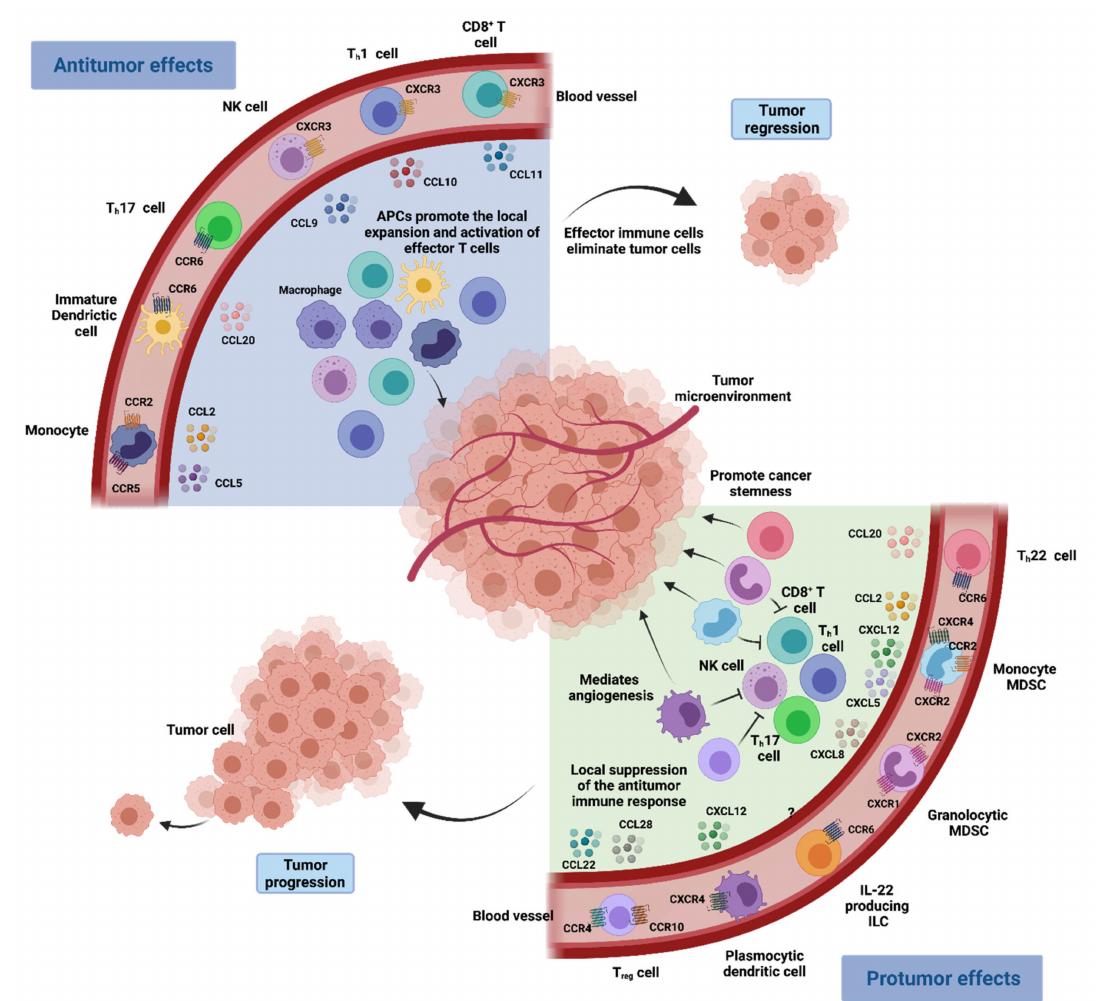
Figure 2. Chemokine network in the tumoral microenvironment immune response. Immune cells with antitumor effects such as CD8 + T cells, T H 1 cells, polyfunctional T H 17 cells and NK cells are attracted to the chemokine–chemokine receptor signalling pathways. CXCR3 and its ligands CXCL9 and CXCL10 have a main role in driving the migration of T H 1 cells, CD8 + T cells and NK cells into the TME, while CCL20 signalling through CCR6 promotes the recruitment of T H 17 cells. Furthermore, antigen presenting cells including macrophages and dendritic cells are also recruited into the TME, where they can activate and expand the local effector immune cells, promoting tumor regression. In turn, immune cell populations such as MDSCs, T reg cells, T H 22 cells, IL-22 + innate lymphoid cells (ILCs) and plasmocytic dendritic cells can promote tumor growth. These cells are recruited to the tumor bed in response to different chemokines that are expressed in the TME (the relevant receptors and ligands are shown). Immune cells with pro-tumorigenic actions may hinder antitumor immune responses and may also mediate and sustain cancer stemness and angiogenesis, resulting in cancer